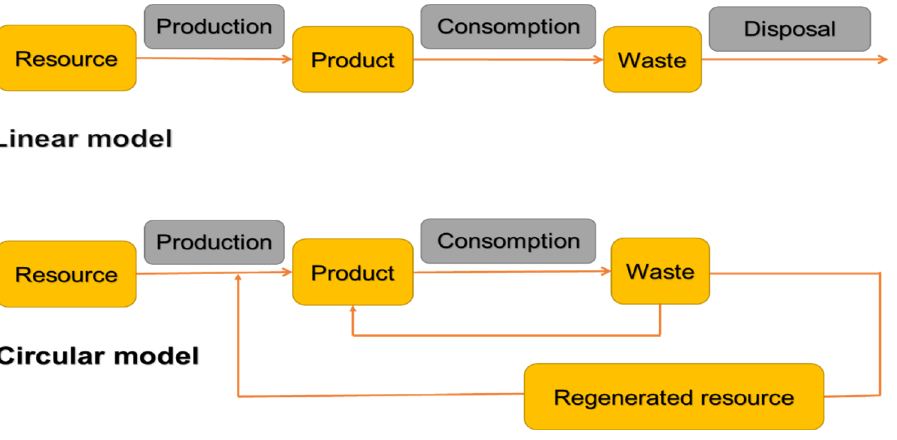
Figure 2. Linear excavated soil management model vs. circular excavated soil management model.